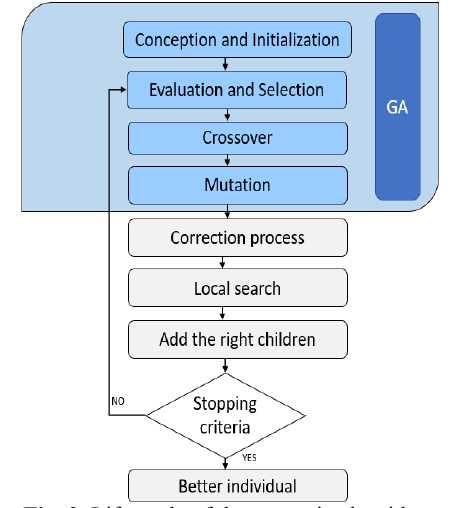
Fig. 2. Life cycle of the memetic algorithm.